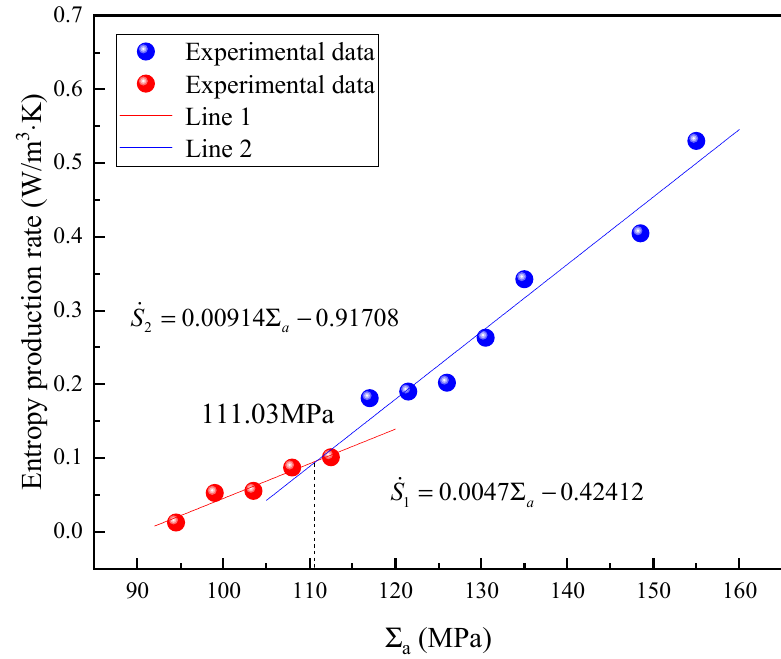
Figure 8. Fatigue limit prediction based on the developed method.